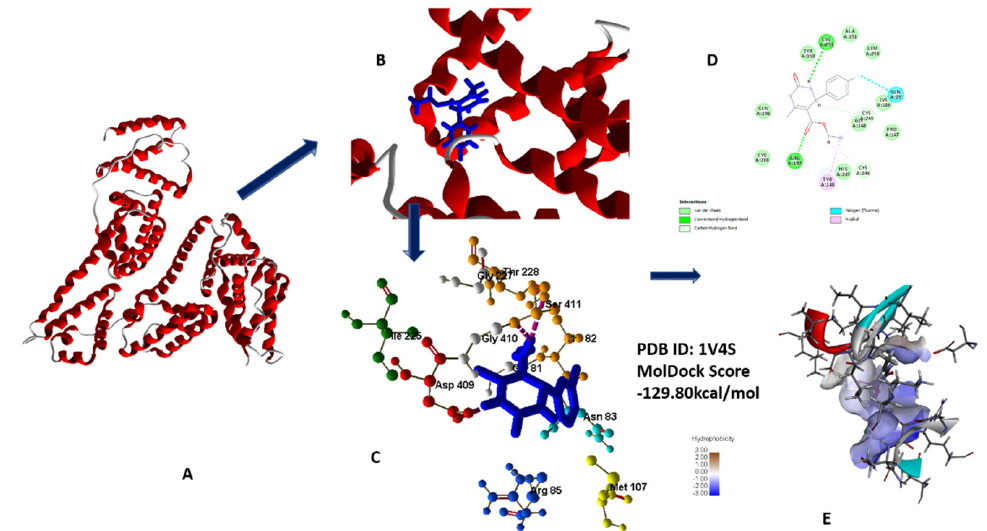
Figure 11. ( A ) Secondary structure of 1V4S; ( B ) secondary structure along with lead compound 5g ; ( C ) 3D interaction with protein; ( D ) 2D diagram; ( E ) hydrophobic interaction of 5g with 1V4S.